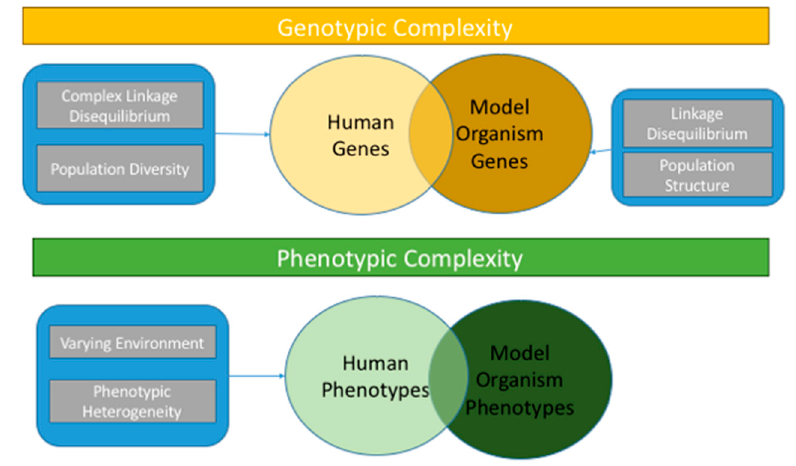
Figure 1. Differences among genotypic and phenotypic complexity in humans and model organisms. The intersection represents orthologous genes (yellow section) and phenotypes (green section).